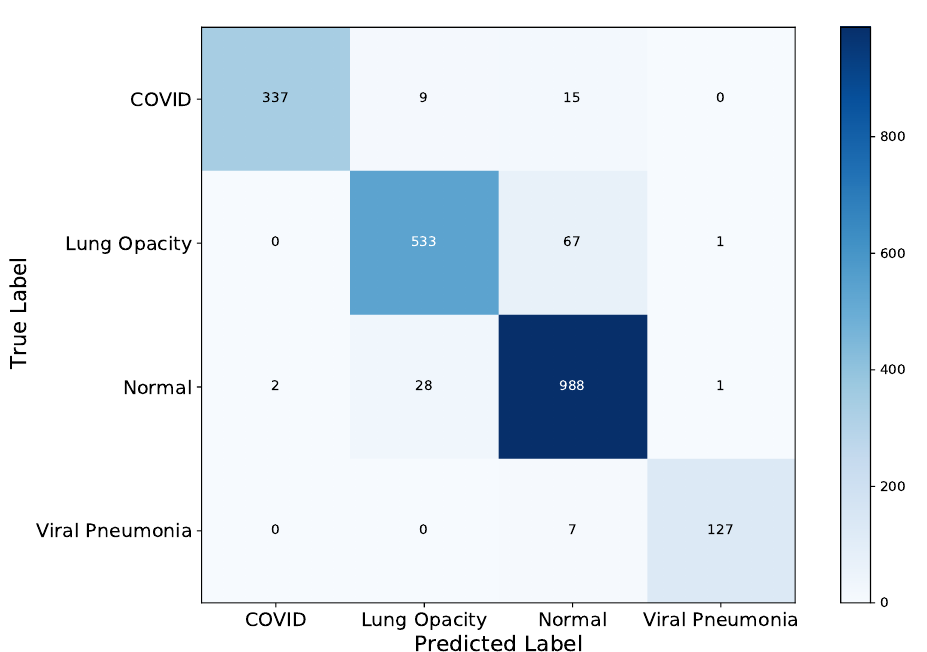
Figure 19. ResNet-50 Confusion Matrix on the left graph. Like the other two models, the Lung Opacity and Normal XCR image classes showed the highest two misclassification. ROC curve